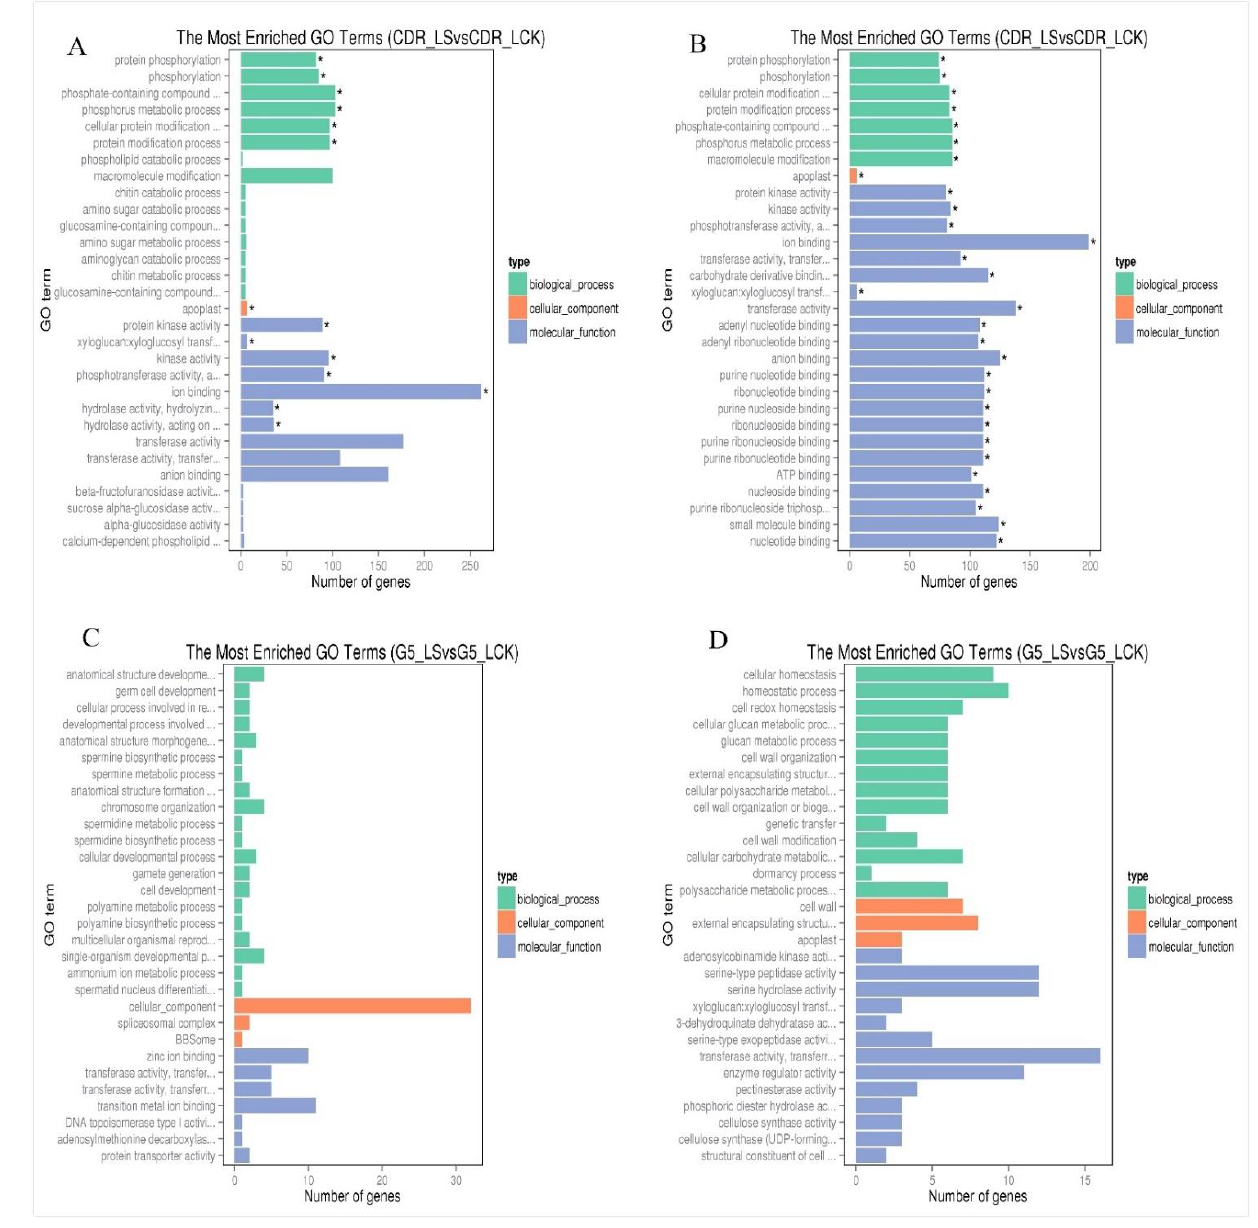
Figure 1. Functional annotation of drought-responsive genes upregulated and downregulated in CDR-1 and Gisela 5 leaves based on Gene Ontology (GO) categorization. ( A ) DEGs upregulated in CDR-1 leaves; ( B ) DEGs downregulated in CDR-1 leaves; ( C ) DEGs upregulated in Gisela 5 leaves; ( D ) DEGs downregulated in Gisela 5 leaves. Asterisks represent significantly enriched